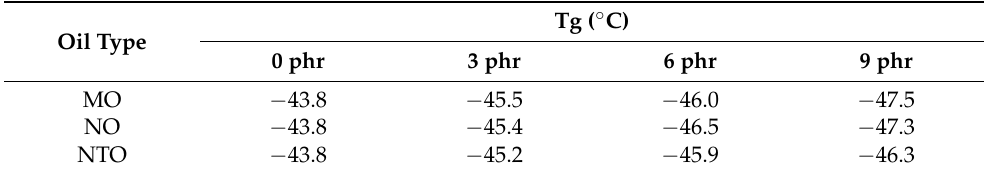
Table 4. Glass transition temperature (Tg) of the rubber compounds plasticized with different oil types and